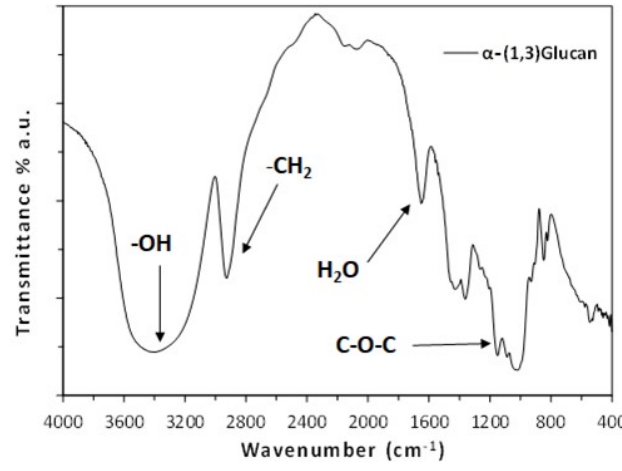
Figure 3 . FT-IR spectrum of dried neat glucan. Figure 3. FT-IR spectrum of dried neat glucan.